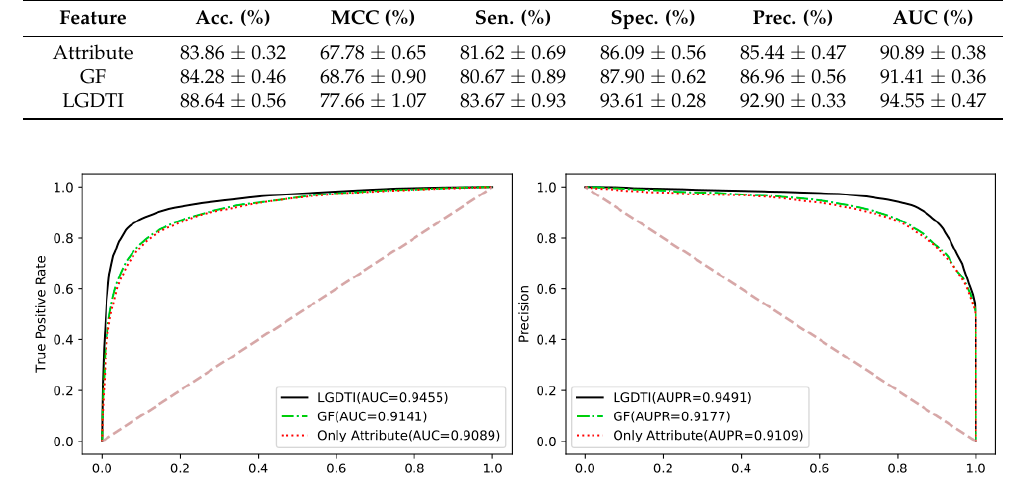
Figure 5. Comparison of the ROC and PR curves performed based on different machine learning classifier.